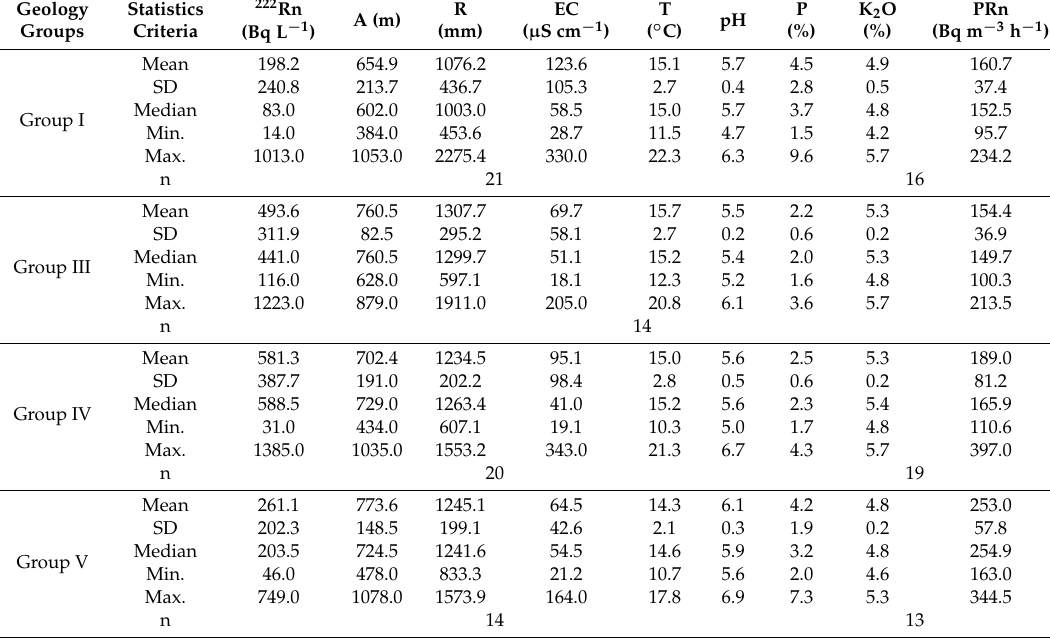
Table 1. Descriptive statistics for climatic, topographic, physical and chemical characteristics, and radiological parameters in water for each geological